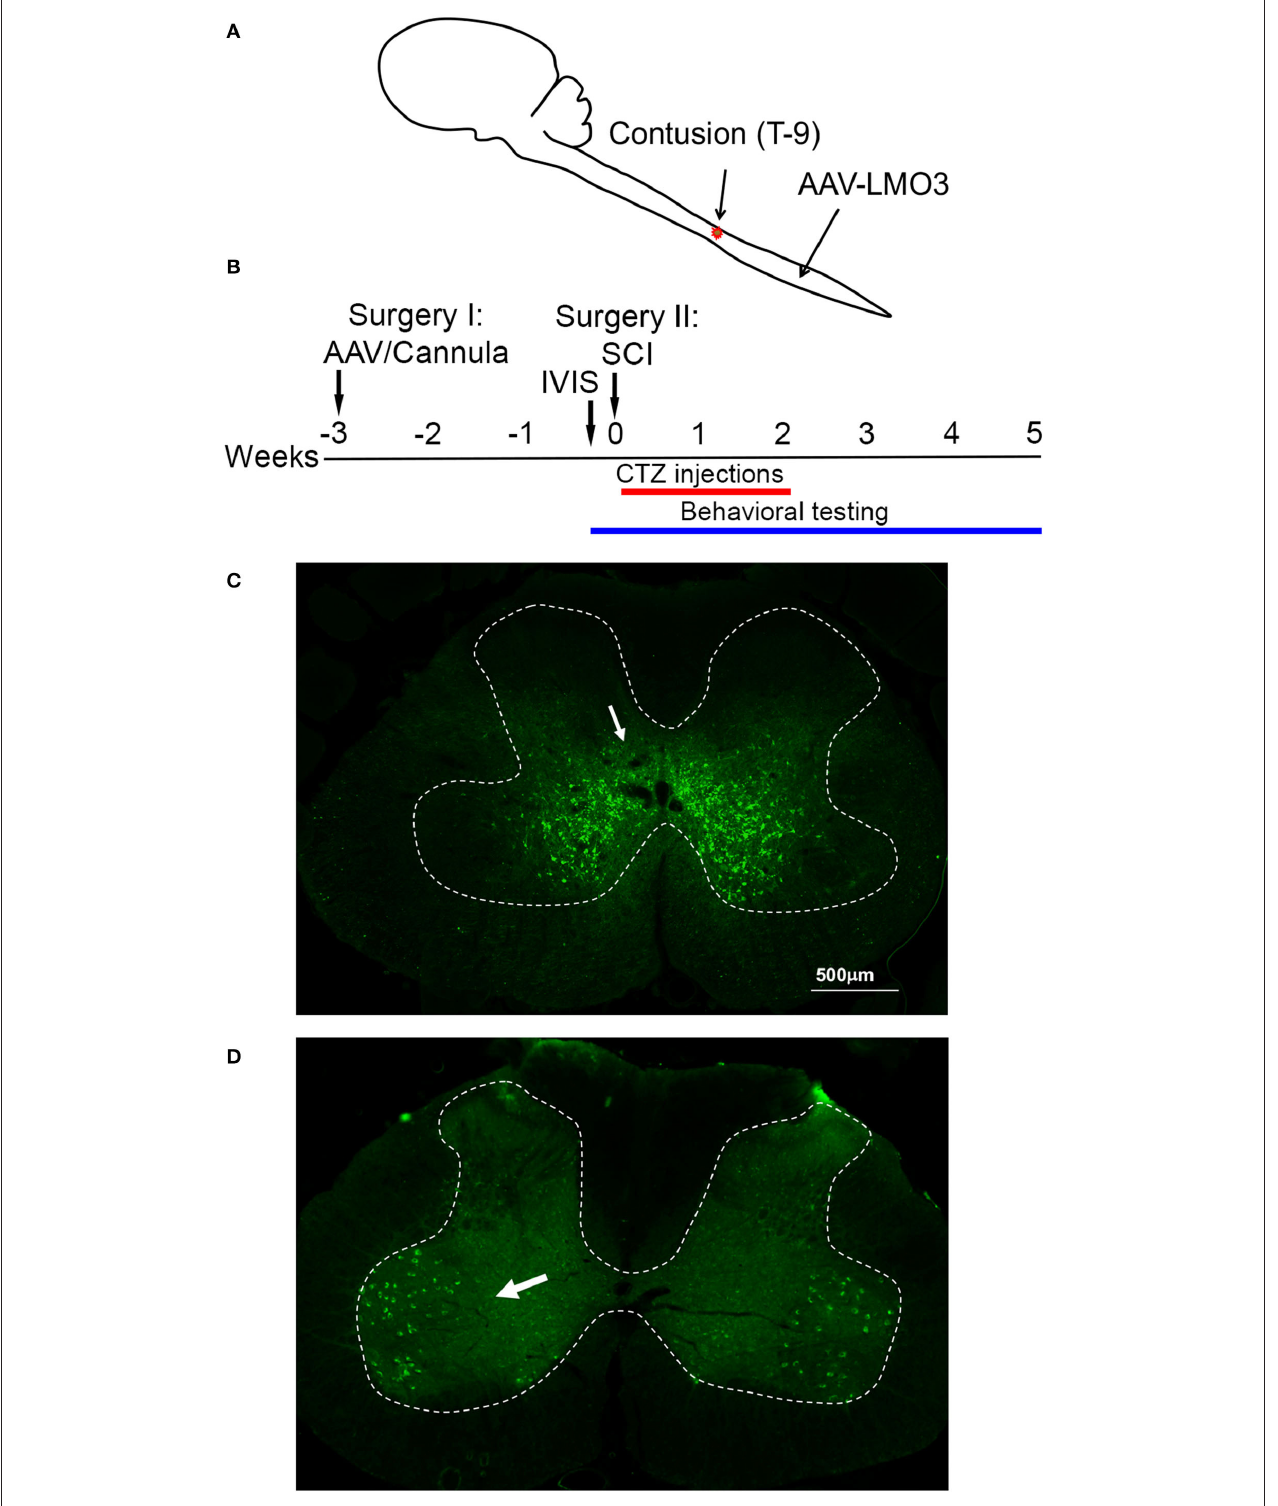
FIGURE 1 | Spinal cord injury model. (A) Schematic of the experimental model with viral injection for BL-OG stimulation in the lumbar enlargement and contusion injury in the thoracic region. (B) Timeline of experimental procedures with the first surgery for lateral ventricle cannula placement and virus injection 3 weeks prior to injury. (C) Expression of AAV 2/9 hSyn-LMO3 in the lumbar spinal cord (arrow pointing to expressing interneurons). The highest levels of expression are restricted to